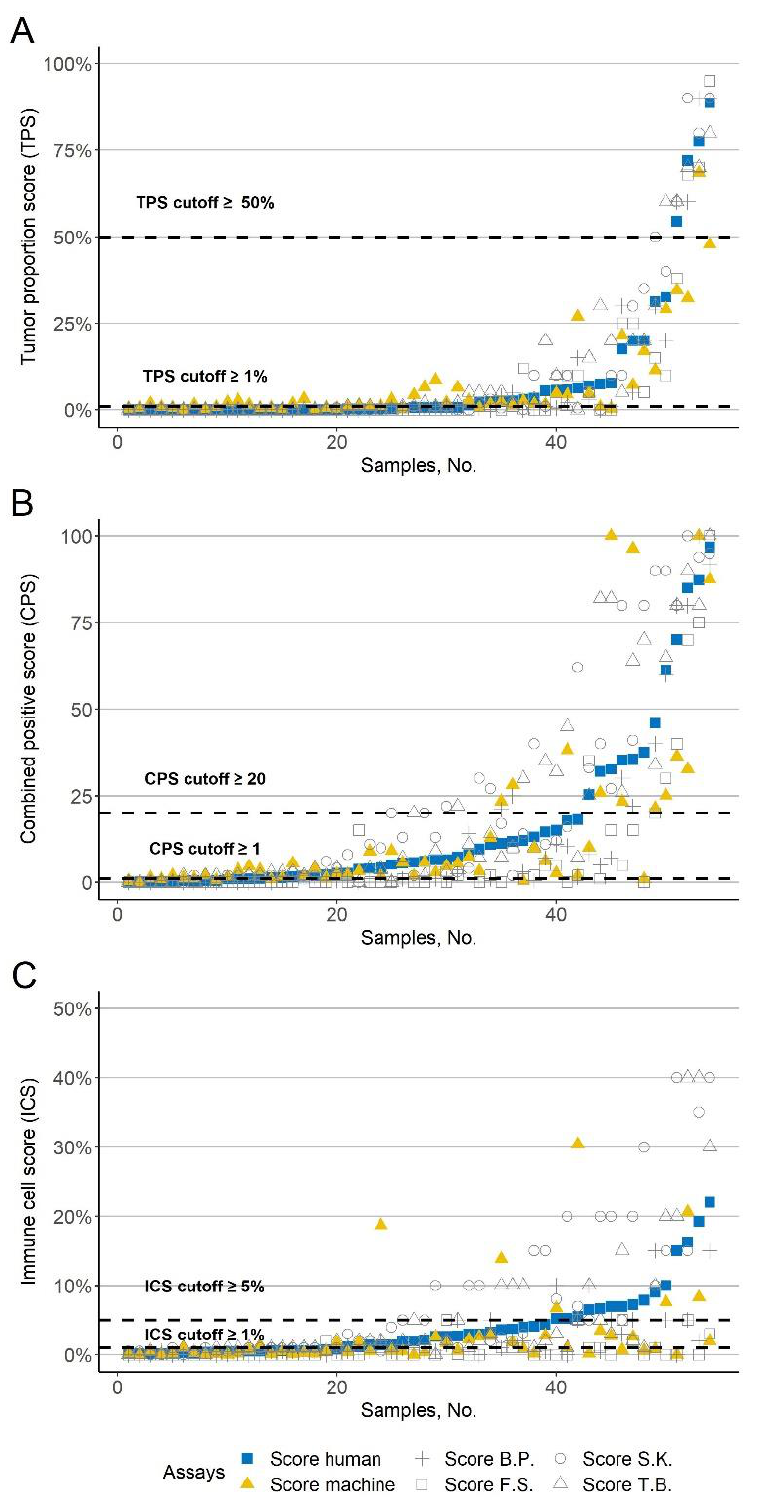
Figure 3. Results of PD-L1 scoring. ( A – C ) Three PD-L1 scores for all cases. ■ PD-L1 average score of the four human investigators. ▲ Automated PD-L1 score based. The gray symbols correspond to the four investigators (+ B.P., □ F.S., ○ S.K., and △ T.B.); The x -axis shows the samples. The y -axis shows the corresponding PD-L1 scores. The dashed line indicates common cutoffs. The values are sorted in ascending order according to the PD-L1 average score of the four investigators. ( A ) Tumor proportion score (TPS). ( B ) Combined positive score (CPS). ( C ) Immune cell score (ICS).